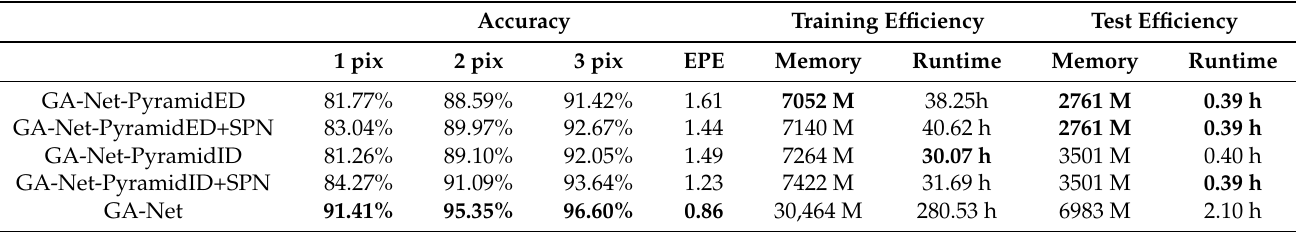
Table 1. Accuracy and efficiency comparison between GA-Net-Pyramid, including GA-Net- PyramidED and GA-Net-PyramidID, and GA-Net on Scene Flow